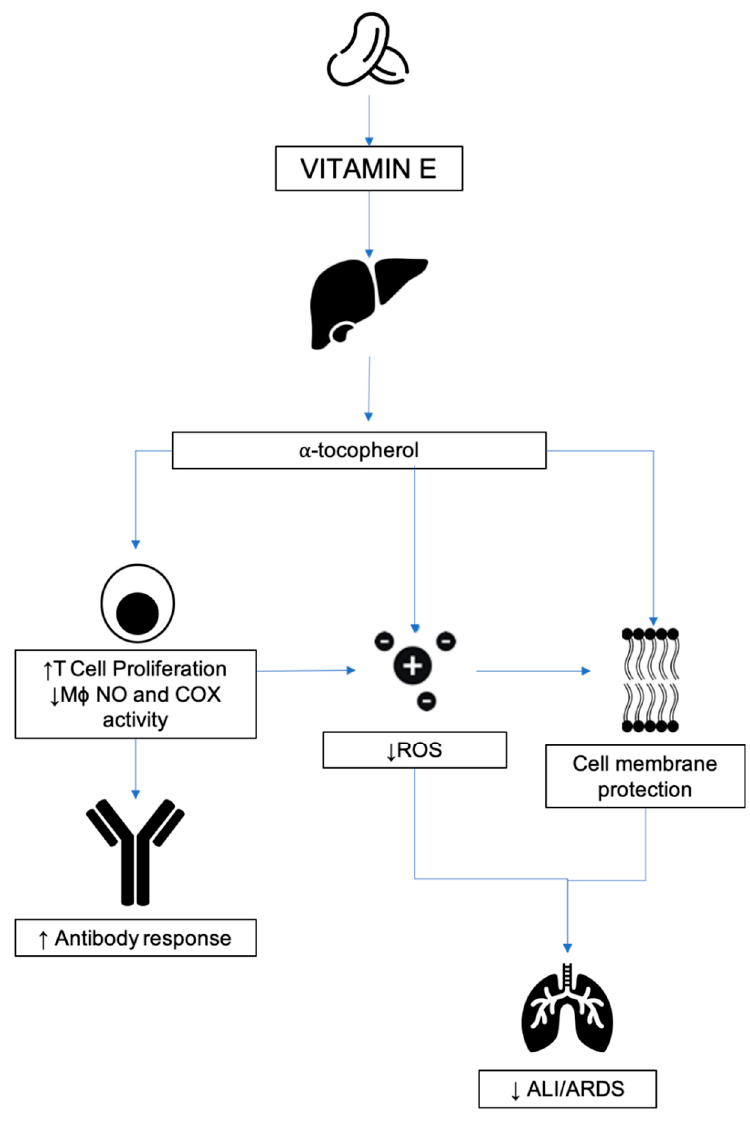
Figure 10. Vitamin E and potential anti-COVID19 mechanisms of action in ARDS. The antioxidant properties of Vitamin E derivatives may augment cell membrane integrity and improve the adaptive immune system response to viral respiratory tract